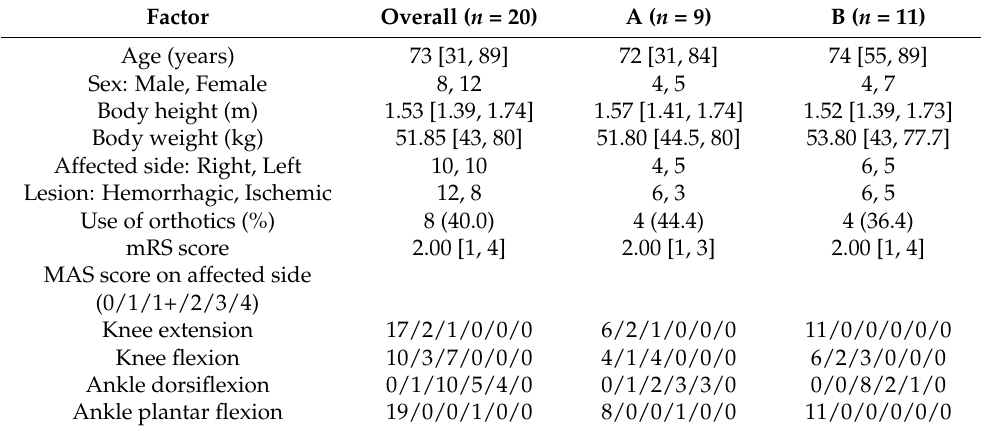
Table 1. Characteristics of subjects.